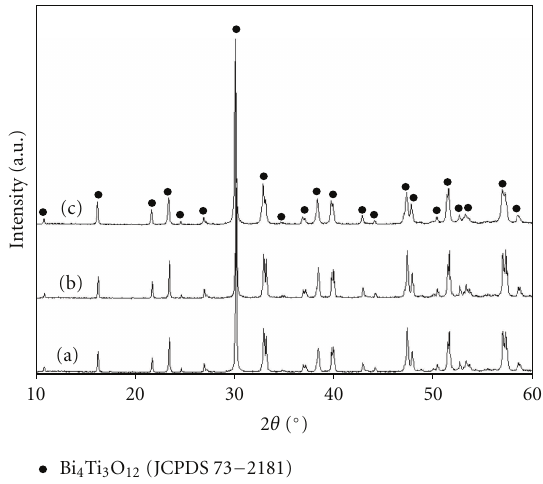
Figure 1: The XRD pattern of BiT powders at di ff erent calcination temperatures for 3 hours: (a) 900 ◦ C, (b) 1000 ◦ C, and (c) 1100 ◦ C.